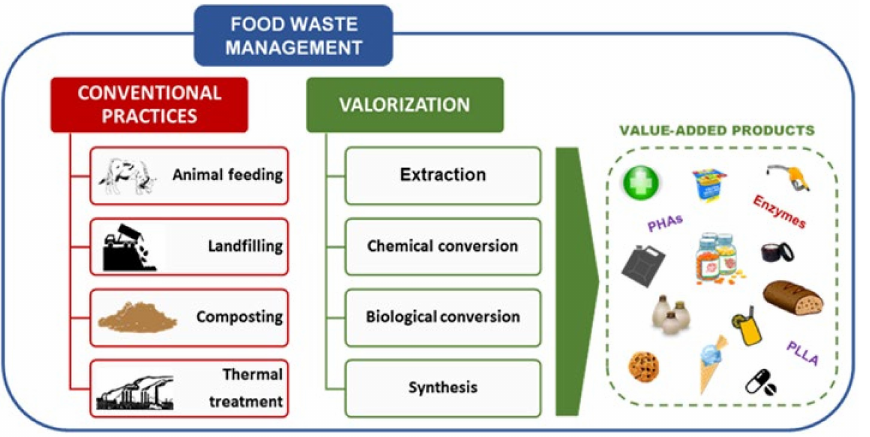
Figure 1. Food waste management practices and the novel or emerging valorization methods. Reproduced with permission from Ref. [17]. Copyright 2021